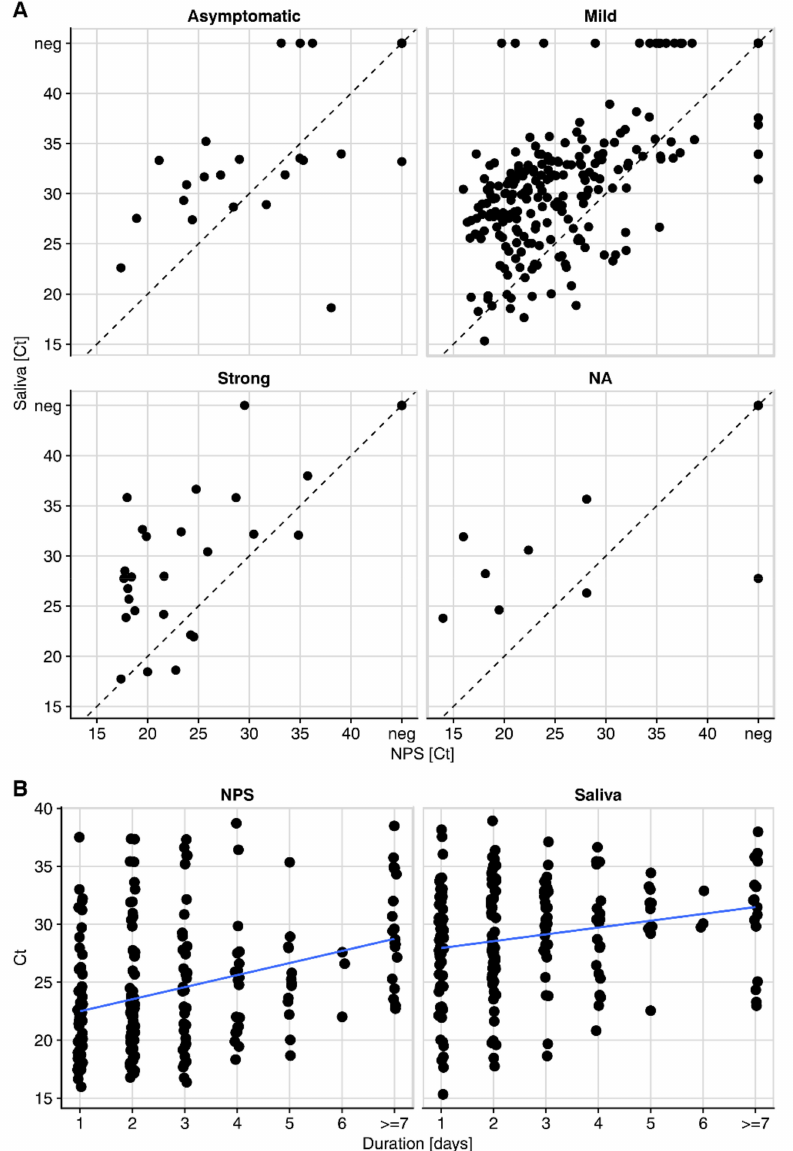
Figure 3. Viral loads in NPS and saliva decrease with ongoing infection. ( A ) E-gene Ct values of NPS and saliva of all pairs from the full cohort stratified by symptoms. ( B ) Duration of symptoms in symptomatic patients (N = 927) versus E-gene Ct values in saliva and NPS. neg = PCR negative; line shows linear